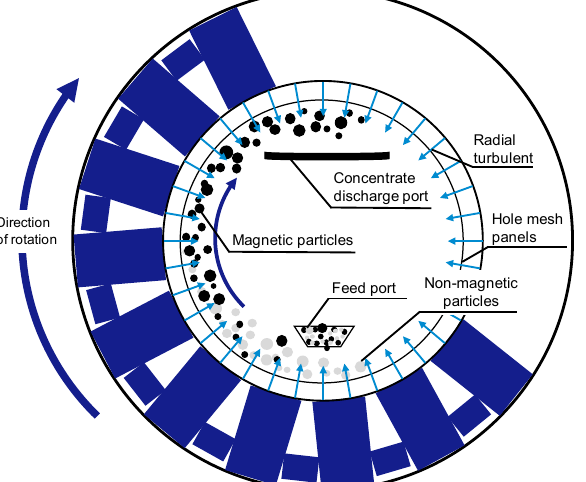
Figure 4. The separation scheme diagram of the radial turbulent outer-cylinder magnetic